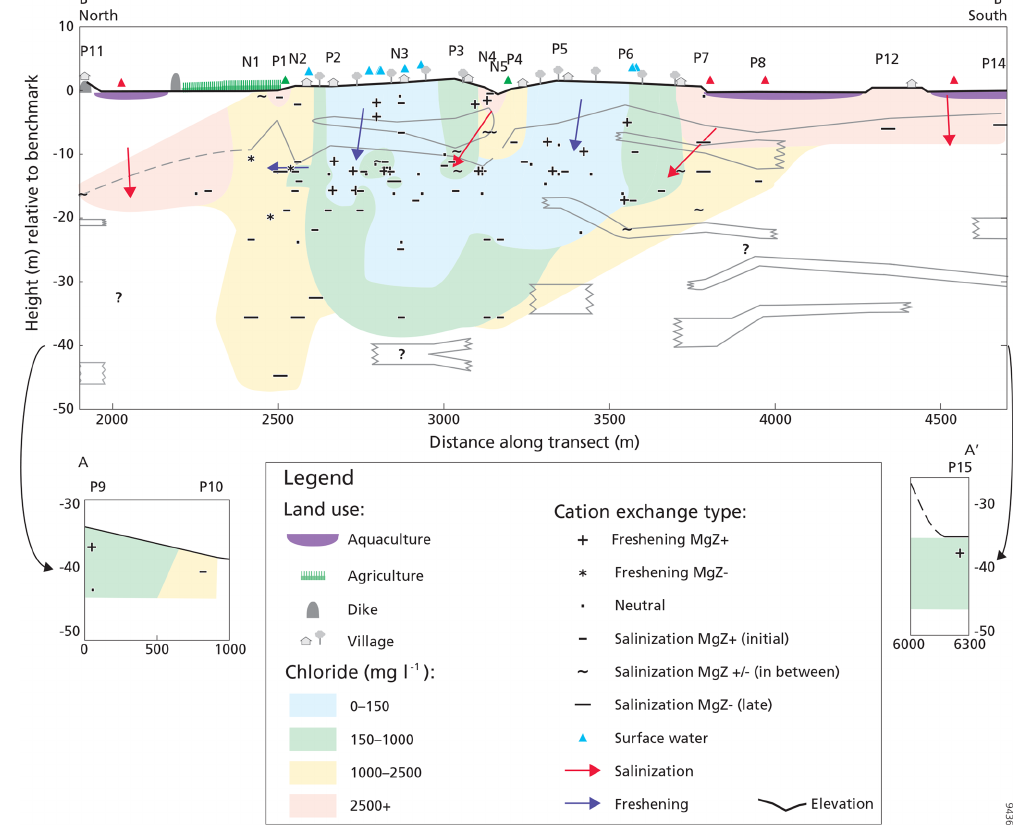
Figure 7. Cation exchange types of the sampled groundwater and the phreatic water from the surface clay